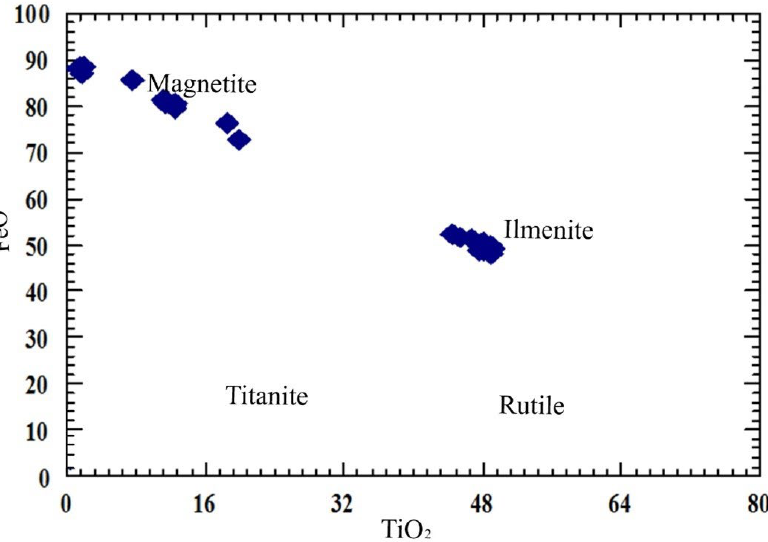
Figure 12. FeO (wt.%) versus TiO 2 (wt.%) variation diagram showing the chemical constituents of the studied minerals [24].